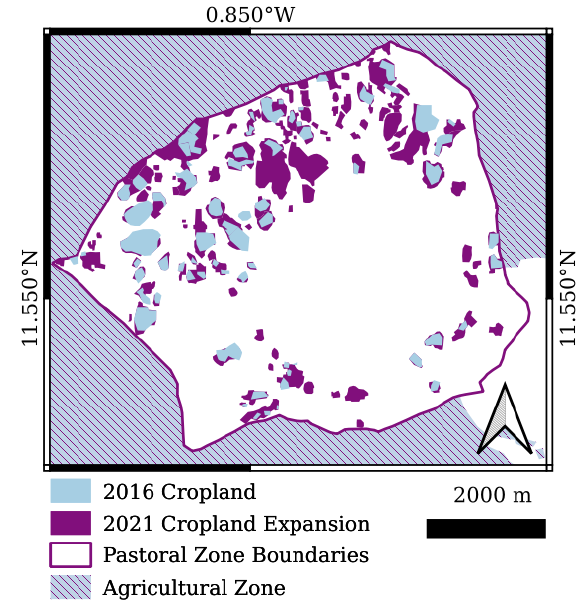
Figure 10: Cropland changes in the Niassa Pastoral Zone between 2016 and 2021,EPSG 4326